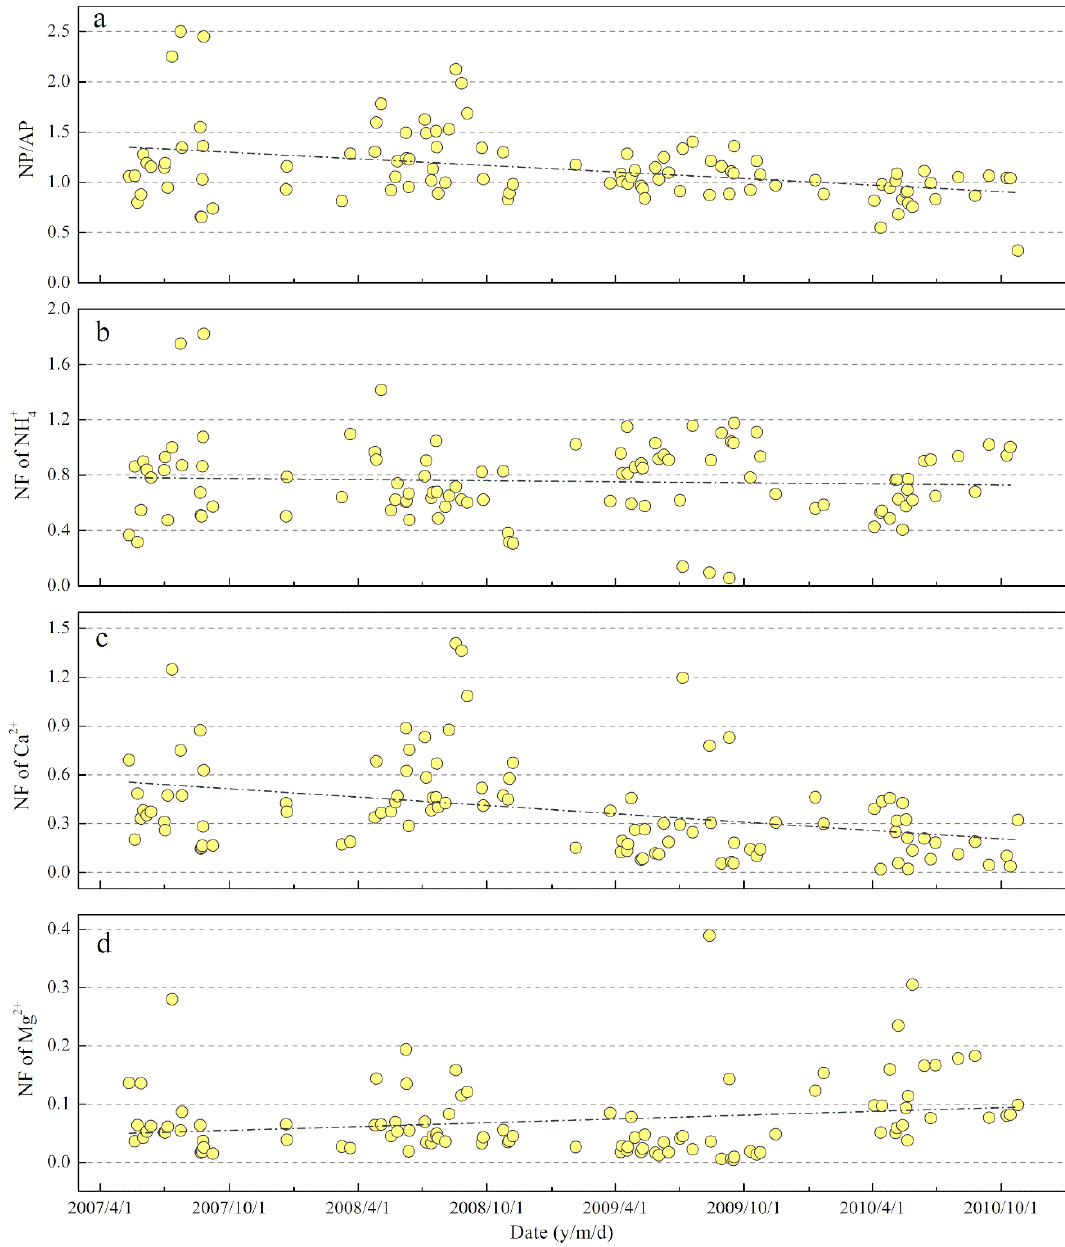
Figure 9. Time series of ( a ) neutralizing potential/acidifying potential (NP/AP), ( b ) neutralization factor (NF) of NH 4+ , ( c ) NF of Ca 2+ , and ( d ) NF of Mg 2+ .